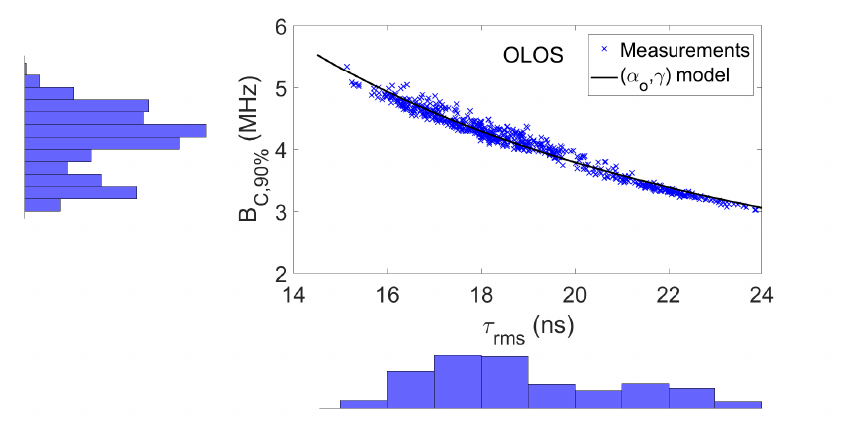
Figure 11. Scatter plot of the 90% coherence bandwidth versus τ rms in OLOS